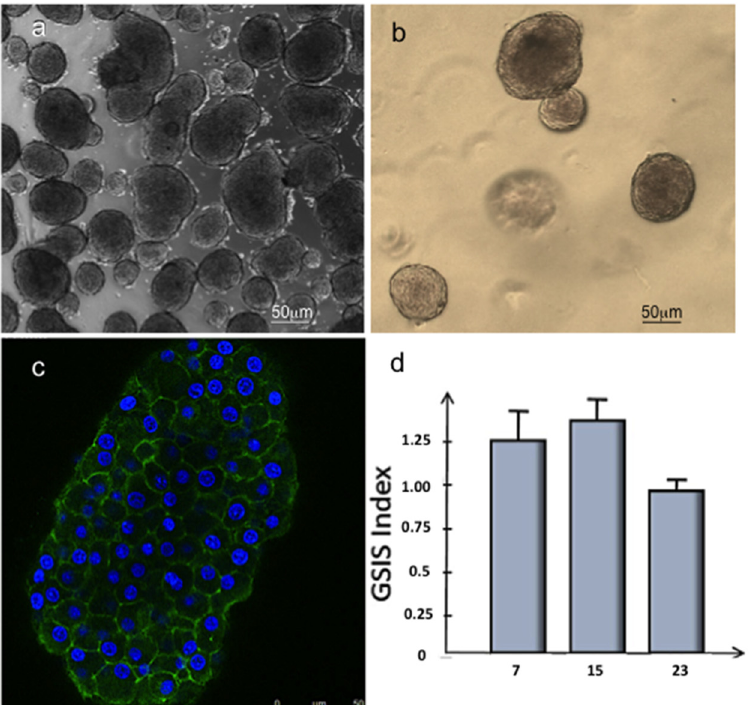
Figure 7. Morphological and metabolical analysis of Langerhans islets. Optical microscopy images of Langerhans islet cultured respectively in 2D conditions after 24 h ( a ) and in 3D collagen hydrogel ( b ) after 15 days. ( c ) Immunofluorescence analysis of Langerhans islet stained with phalloidin-FITC (green) and DAPI (blue) after 15 days of culture in 3D collagen hydrogel. ( d ) GSIS index (the ratio of insulin secreted at 16.7 mM glucose and the insulin secreted at 3.3 mM) of Langerhans islets cultured in 3D collagen hydrogel after 7, 15, and 23 days.